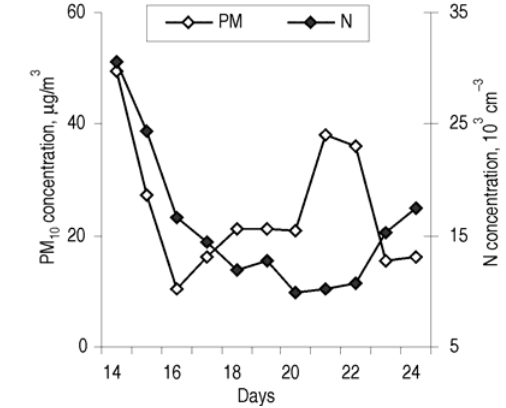
Fig 5 . Variation of 24-hour average of PM 10 concentration and aerosol number (N) concentration on 14–24 October 2005